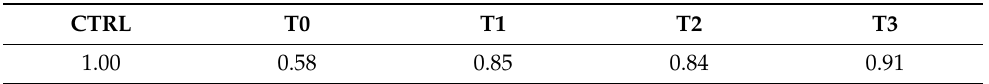
Table 3. IFN scores calculated through the median of the relative quantifications of the six interferon- stimulated genes (ISGs) of the interferon signature analysis after administration of higher-dose sulforaphane (SFN) supplement in the first healthy volunteer (HV1).